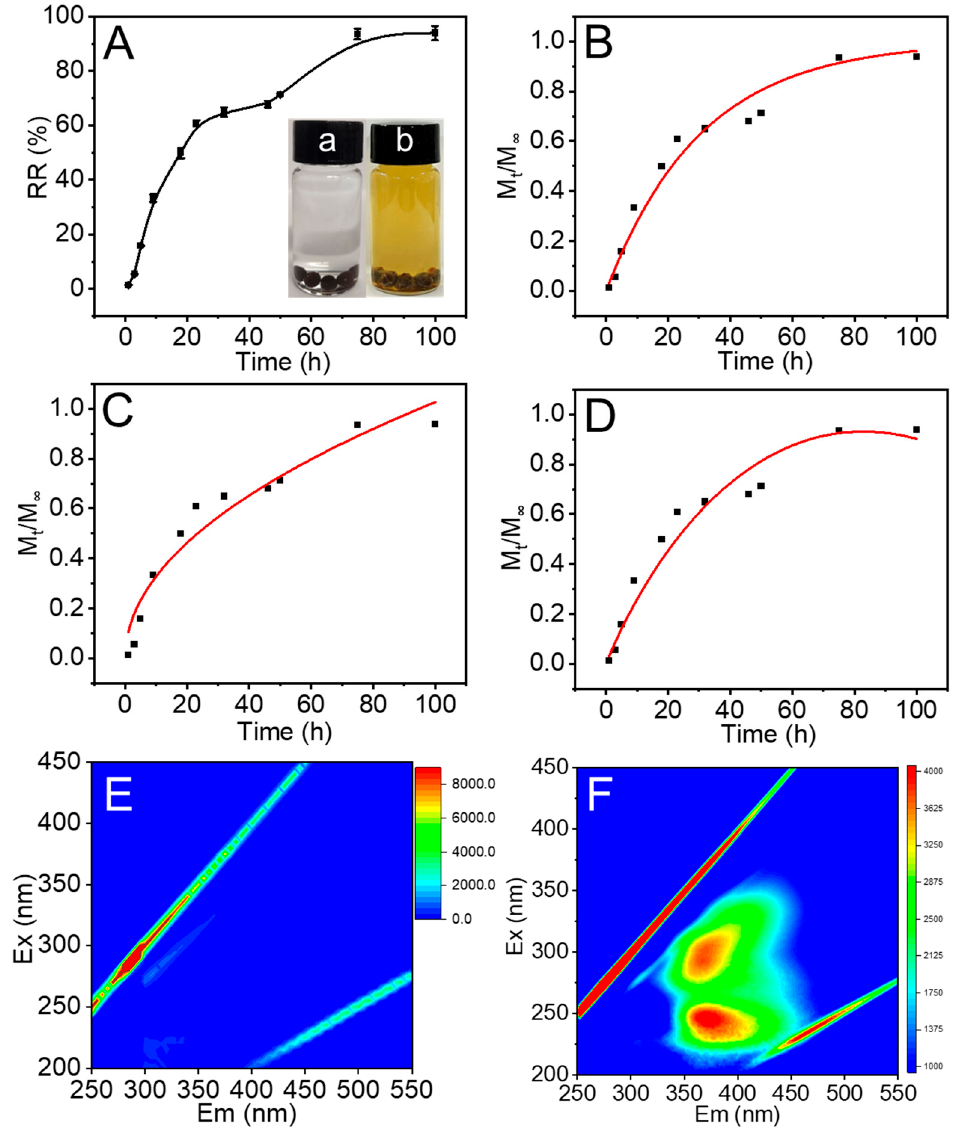
Table 1. Kinetic fitting parameters of FA from OACT@ASO in water.